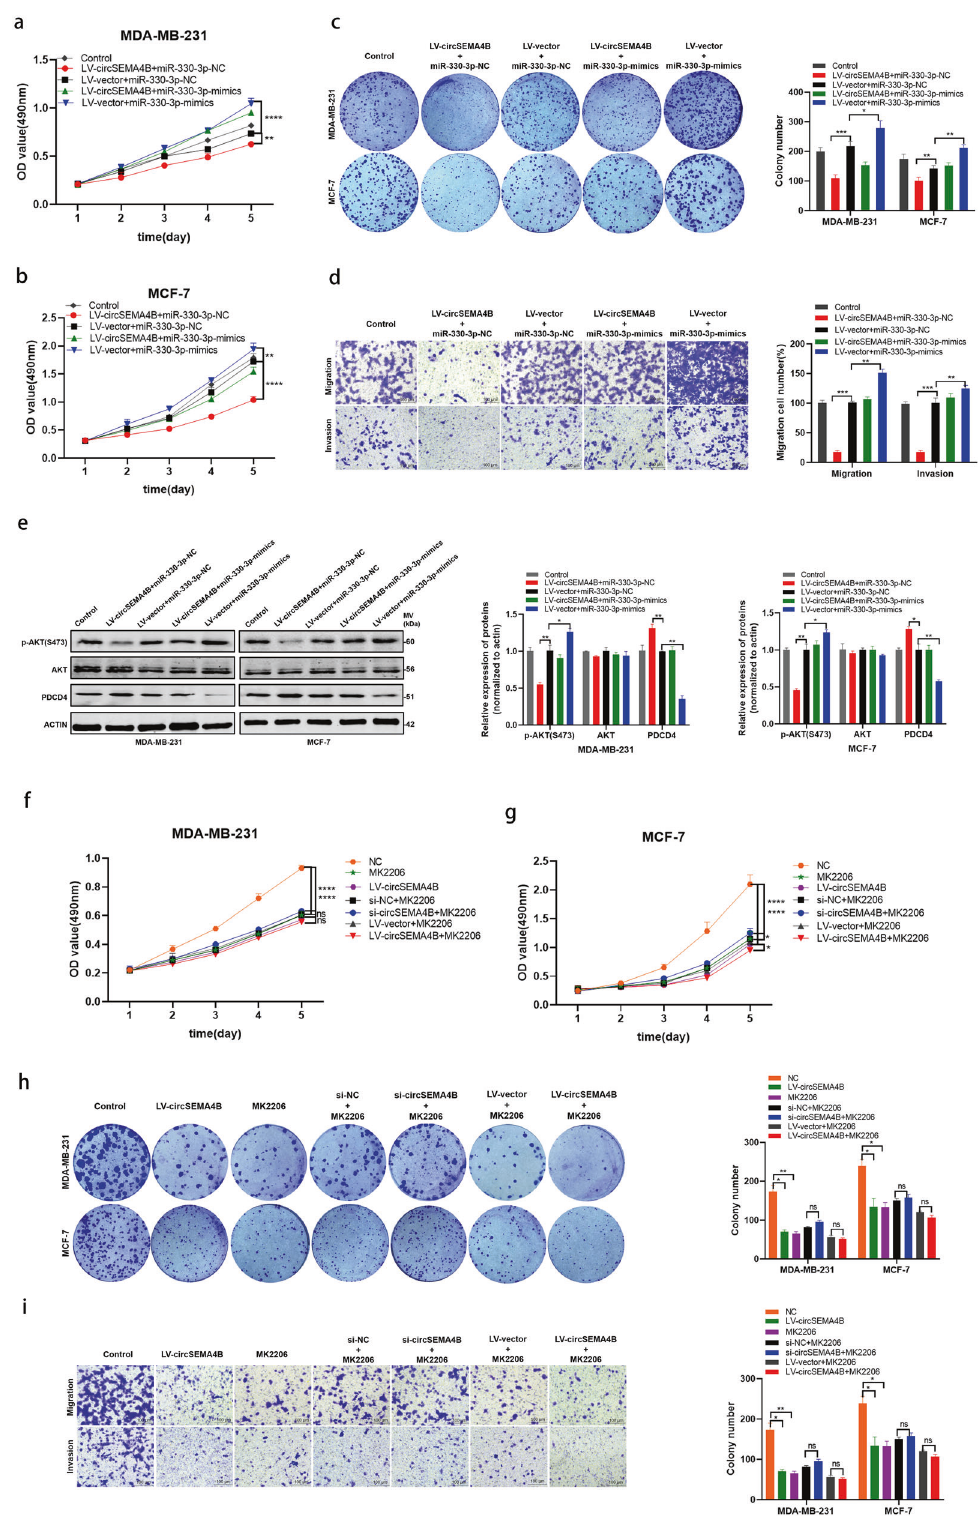
Fig. 7 CircSEMA4B regulates PDCD4 and PI3K/AKT pathway through acting as a sponge for miR-330-3p. a , b miR-330-3p-mimics rescued the suppressive effects of LV-circSEMA4B in BC cells by MTT assay. c miR-330-3p-mimics rescued the suppressive effects of LV-circSEMA4B in BC cells by colony formation assay. d miR-330-3p-mimics rescued the suppressive effects of LV-circSEMA4B in BC cells by transwell assay. e Western blot showed that miR-330-3p-mimics can partly rescue the high expression of PDCD4 and low expression of p-AKT(S473) caused by LV-circSEMA4B in BC cells. f , g Effect of circSEMA4B on proliferation in BC cell lines treated with MK2206 by MTT assay. h Effect of circSEMA4B on proliferation in BC cell lines treated with MK2206 by colony formation assay. i Effect of circSEMA4B on migration and invasion in MDA-MB- 231 cell line treated with MK2206 using transwell chambers.